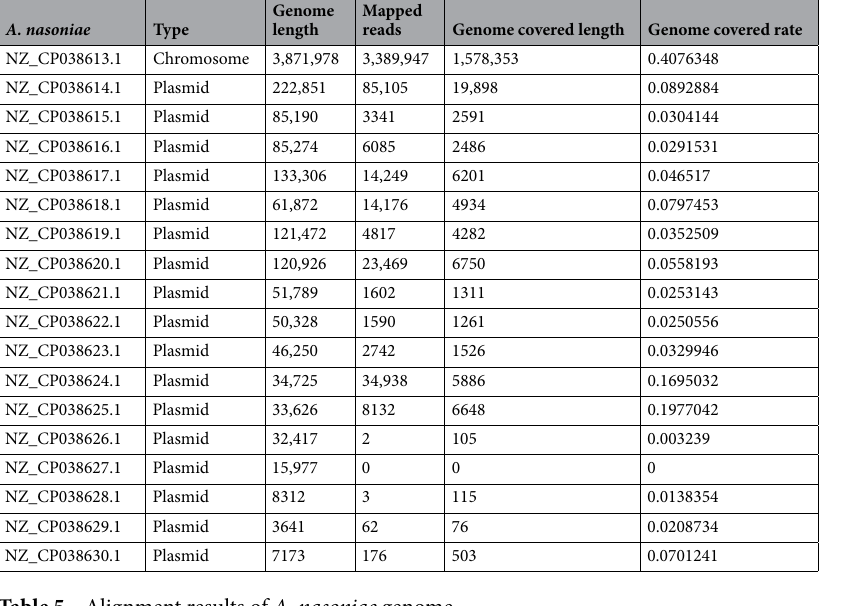
Table 5. Alignment results of A. nasoniae